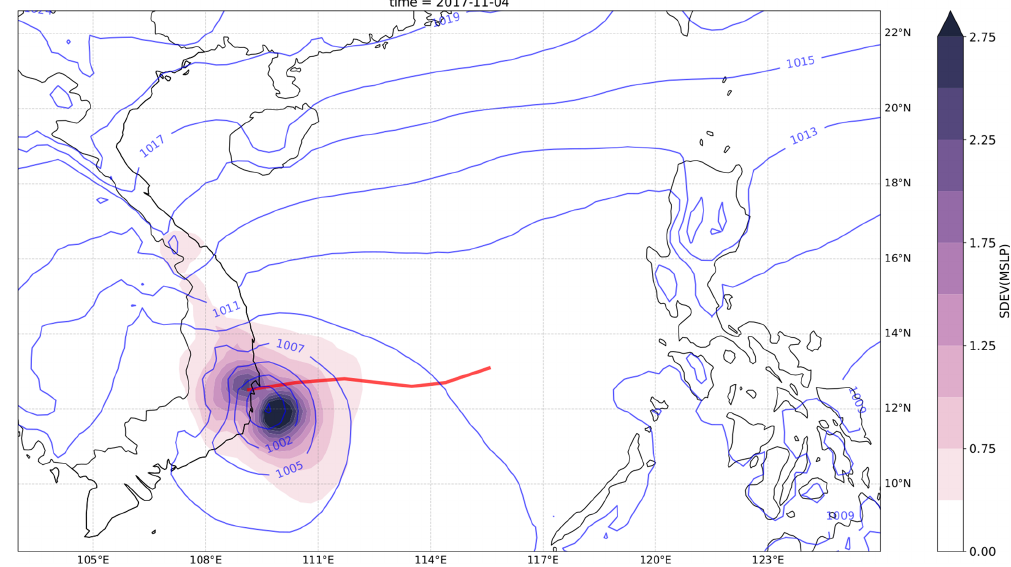
Figure 7. Ensemble mean MSLP (violet contour lines) and ensemble spread (coloured contours) at a T L 639 resolution. The 36h forecast was initialized on 2 November at 12:00UTC. The observed track of Typhoon Damrey between 2 November at 12:00UTC and 4 November at 00:00UTC (red